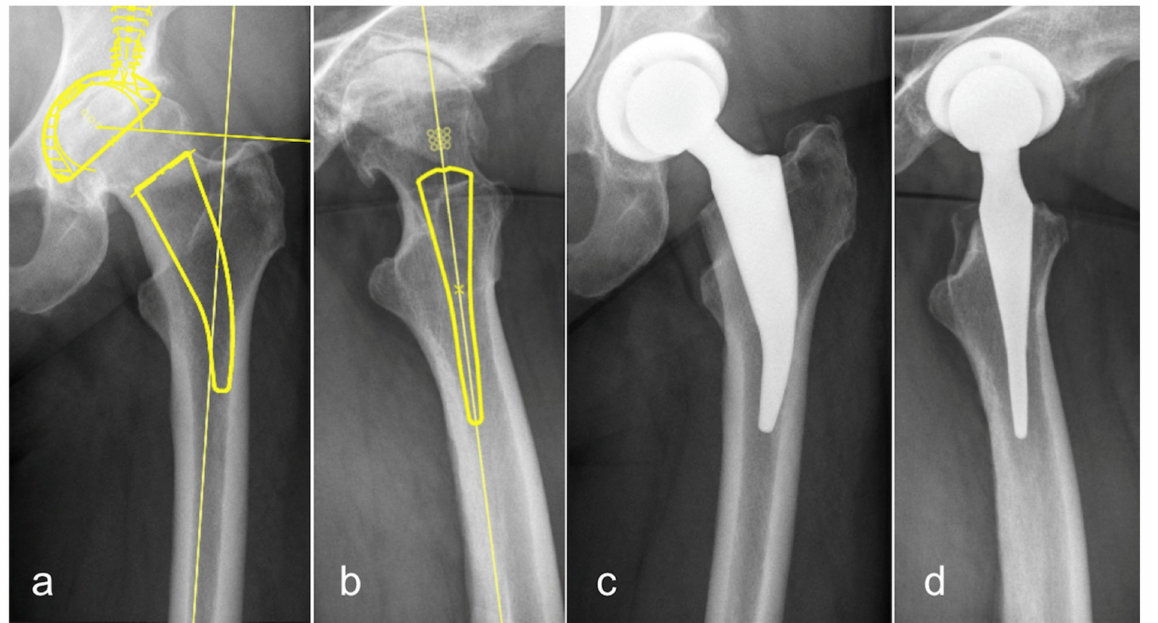
Figure 3. Digital templating of the METHA stem (STHA) in an anteroposterior ( a ) and lateral ( b ) view with the correspond- ing postoperative radiographs ( c , d